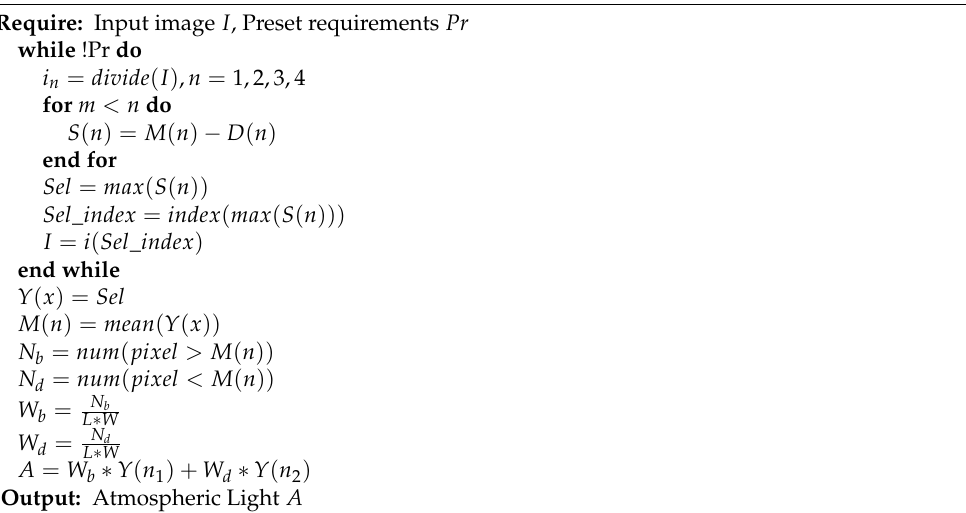
Algorithm 1 Four-point Weighting